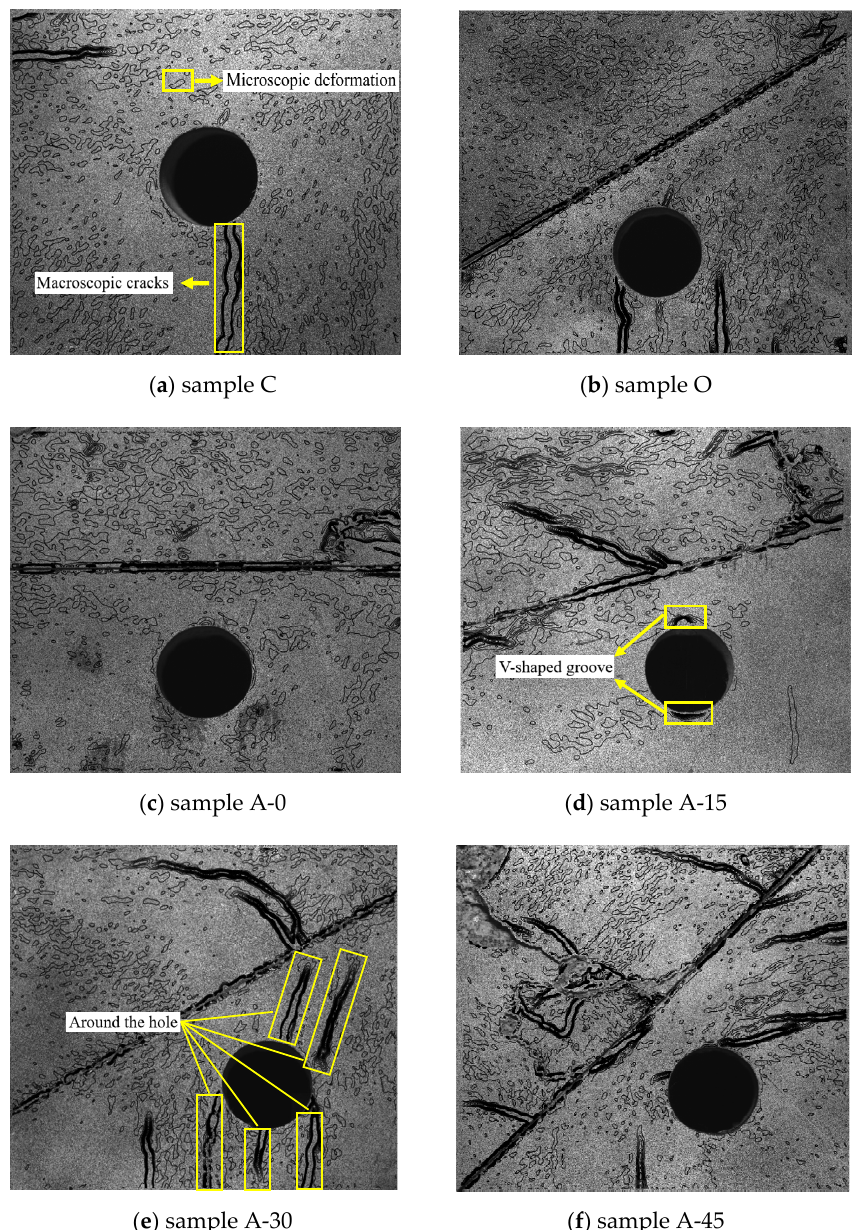
Figure 6. Fracture modes of granite samples with different bonding fracture dip angles.